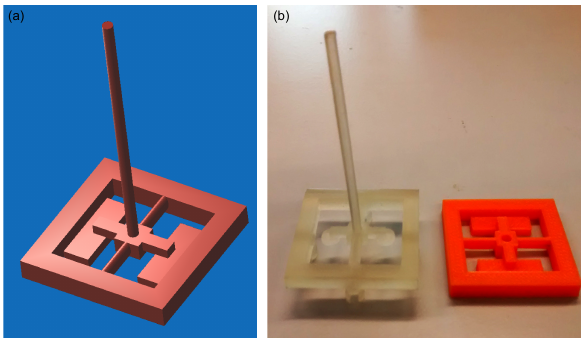
Figure 4. Panel (a) shows the 3-D CAD-design of whisker sensor in OpenScad (OpenScad). Panel (b) shows the printed whisker sen- sor (transparent, Veroclear) and base (red, PLA) (Delamare et al., 2016).